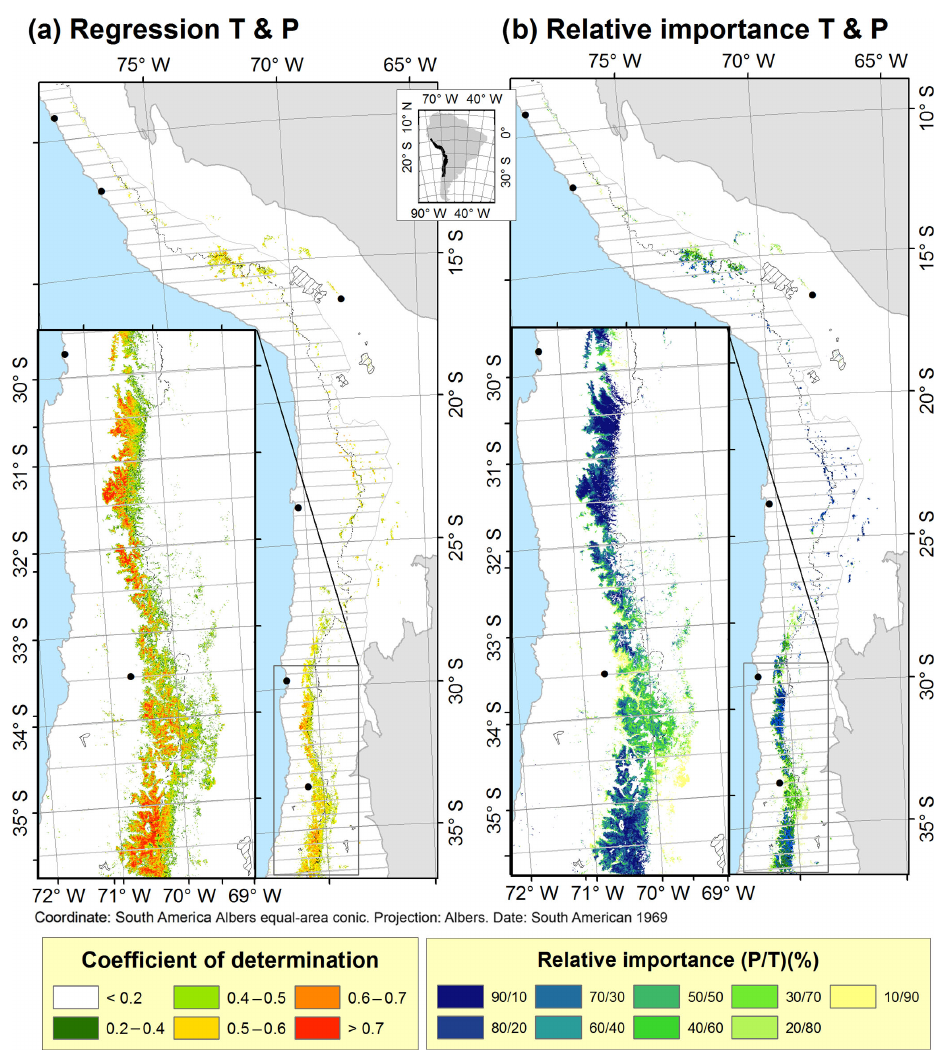
Figure 10. Multiple linear regression analysis by pixel showing (a) the coefficient of determination ( r 2 ) for SP predictions using annual precipitation and mean annual air temperature and (b) relative importance (RI), indicating the proportion of ( P /T ) individual contribution of precipitation to the full r 2 of the